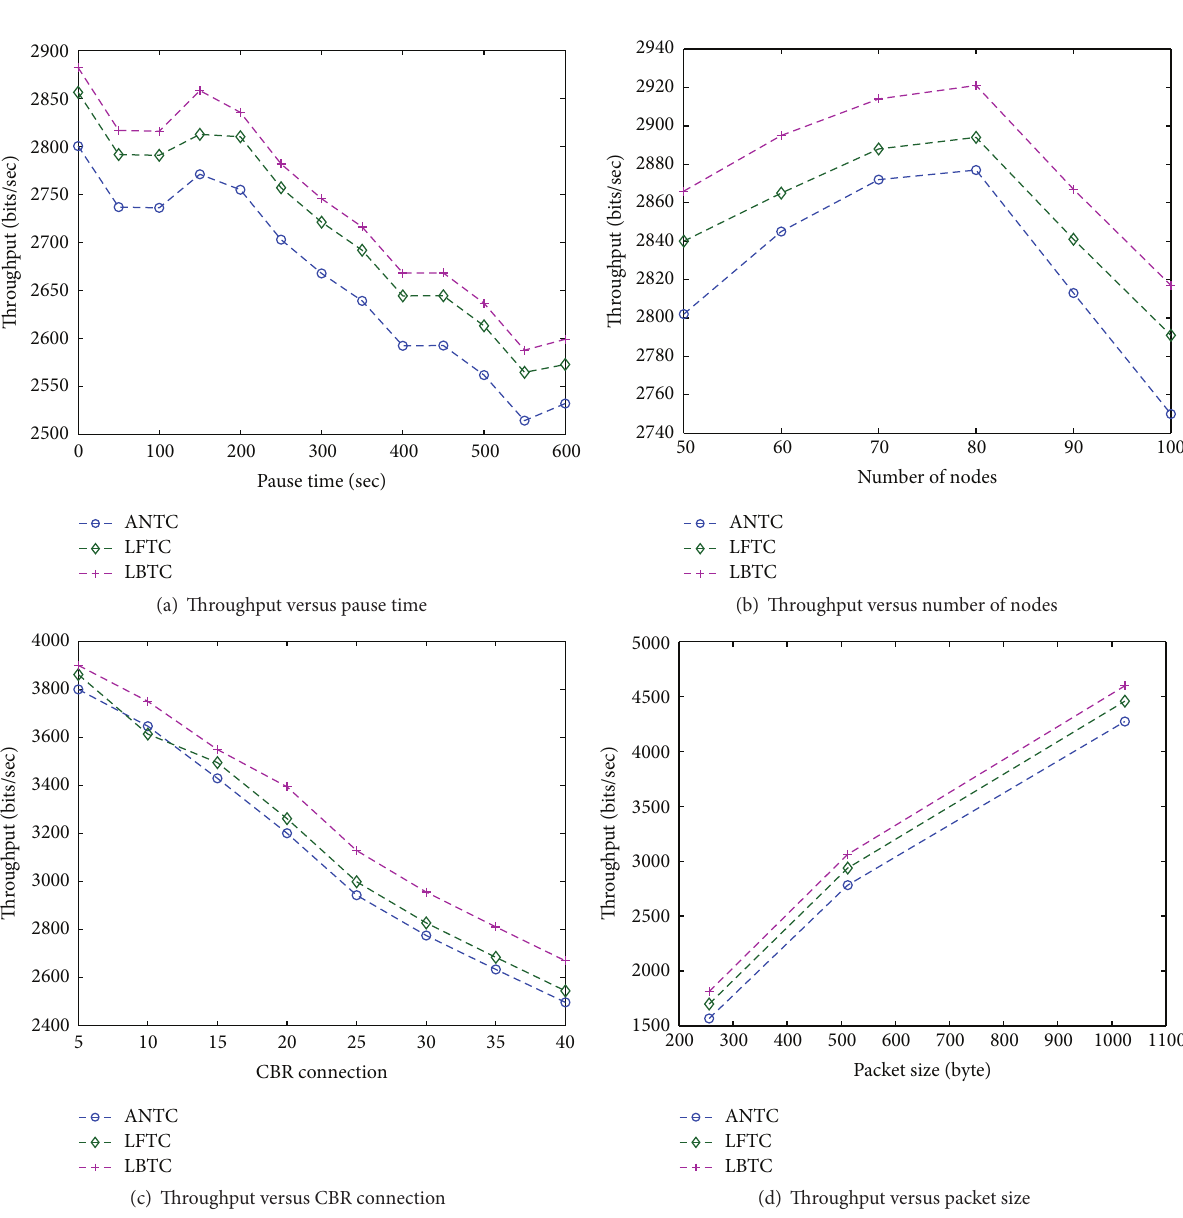
Figure 4: Exemplary network.